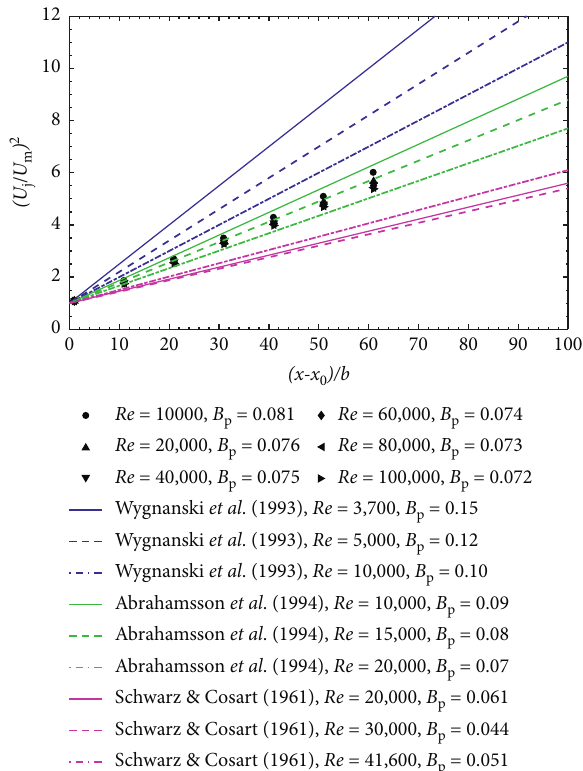
Figure 11: Decay of maximum velocity for various Reynolds numbers.